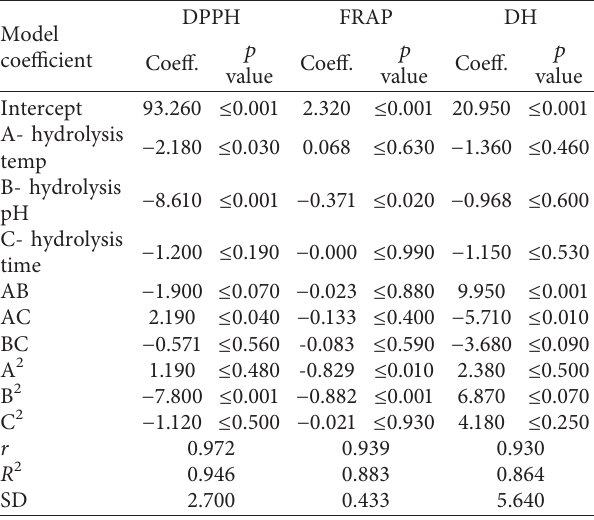
r : correlation coefficient, R 2 : regression coefficient, SD: standard deviation, Coeff.: